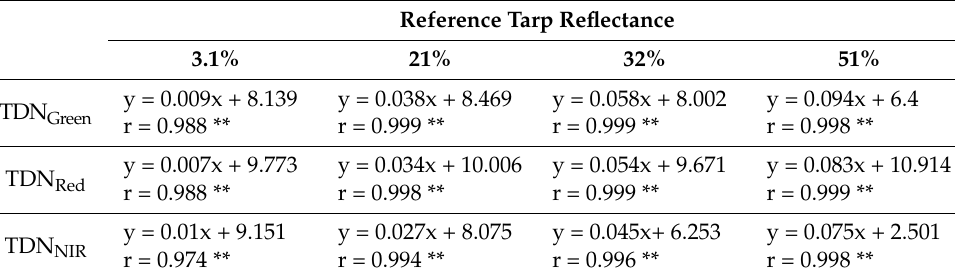
Table 1. Linear regression equations and Pearson’s correlation coefficient (r) of the tarp digital numbers of the green (TDN Green ), red (TDN Red ), and NIR (TDN NIR ) wavelengths with the reference tarp reflectances of 3.1%, 21%, 32%, and 51% obtained using the multispectral camera. Reference Tarp Reflectance 3.1% 21%